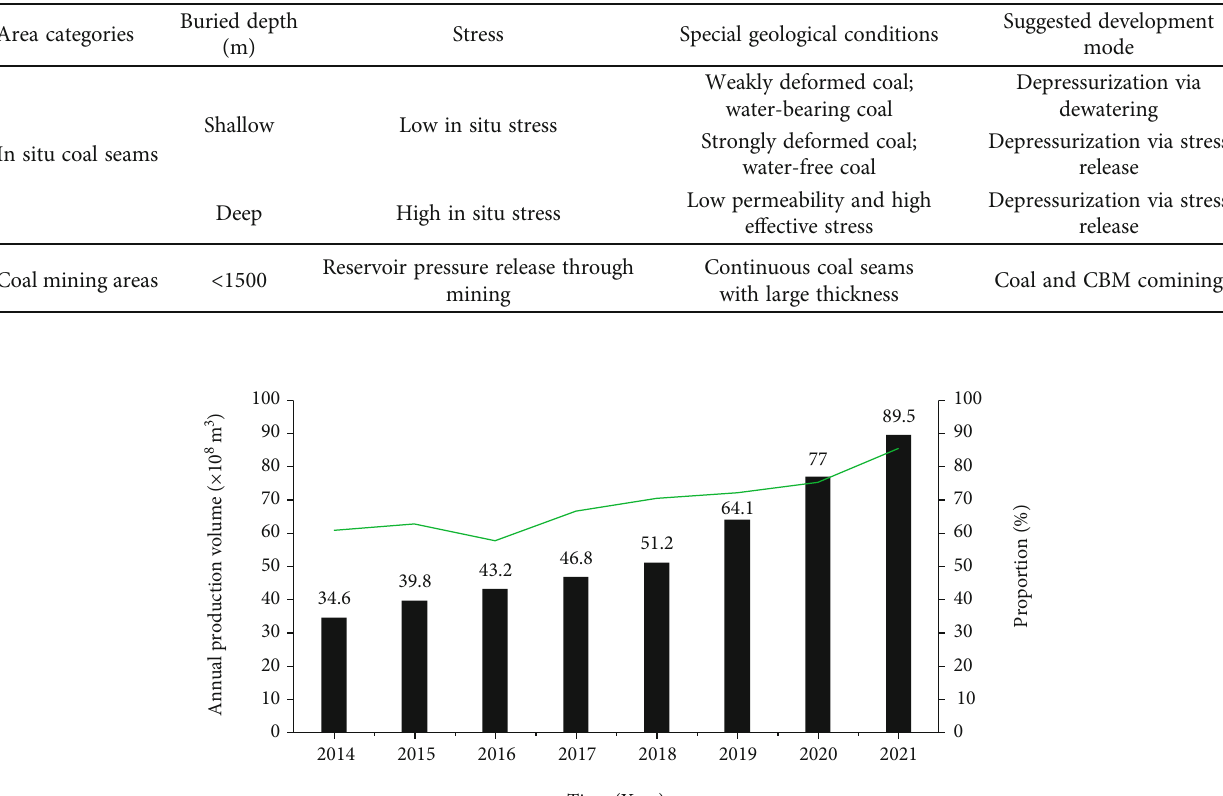
Table 2: Design of CBM development modes.